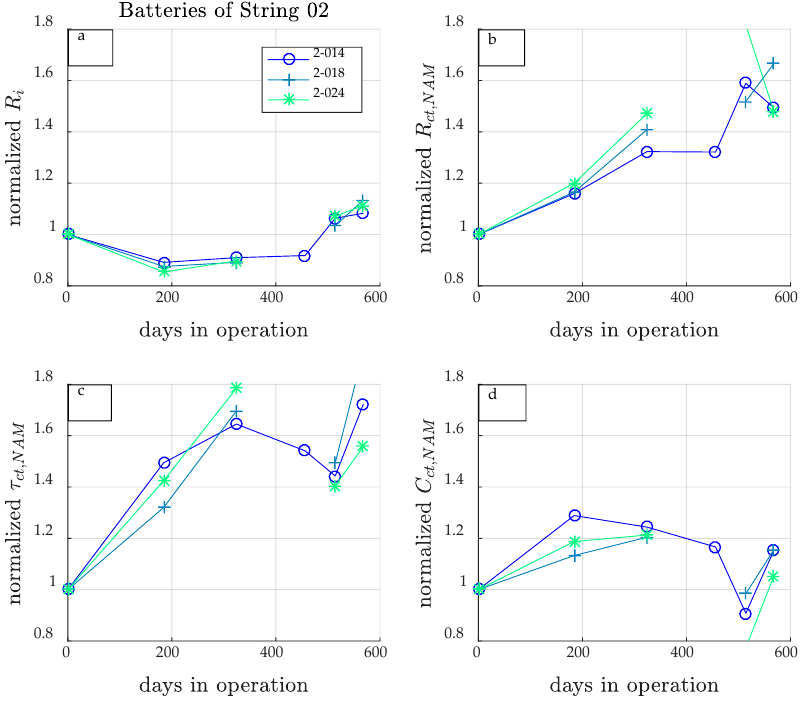
Figure 8. Change of fitted EIS parameters over time for the three batteries of string 2. ( a ) normalized change of the internal resistance R i ; ( b ) normalized change of the charge transfer resistance of the ZARC element; c: normalized change of the time constant τ ct,NAM of the ZARC element; d: normalized change of the capacitance of the CPE.